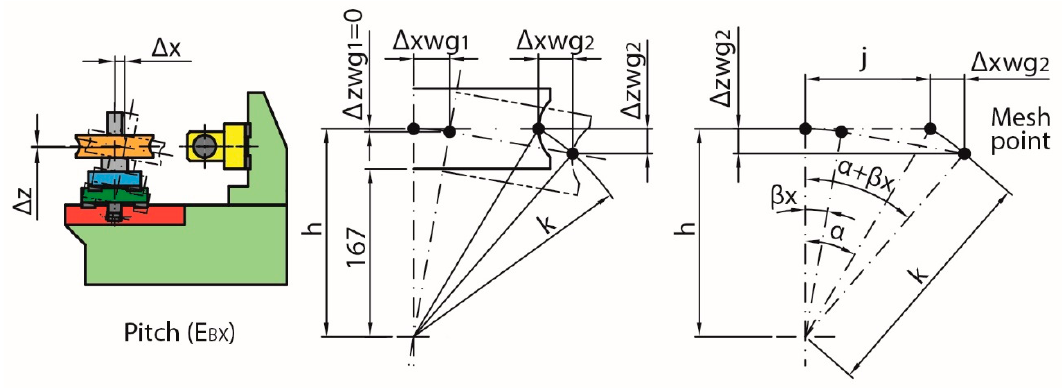
Figure 5. Shift in the worm gear meshing point due to pitch error (E BX ).